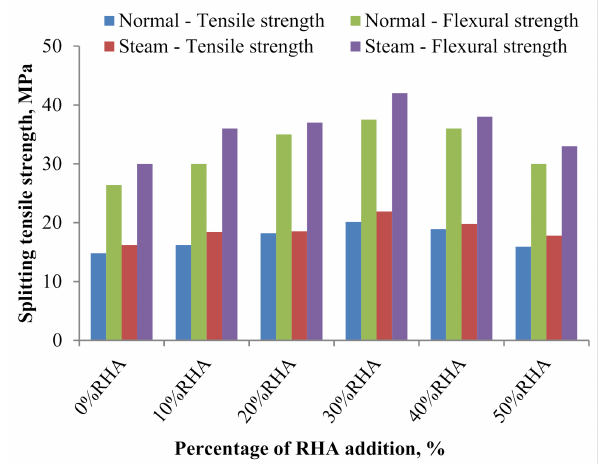
Figure 11. Splitting tensile strength with different levels of RHA replacement